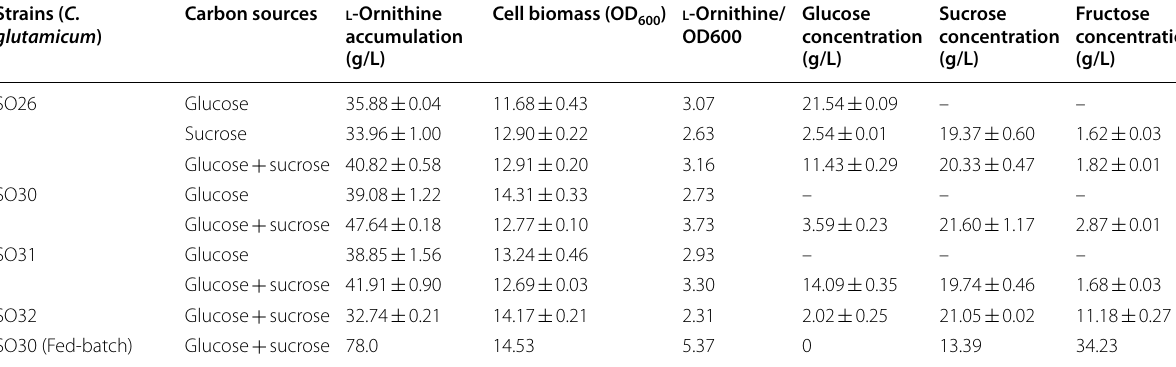
Fermentations were performed at 250 rpm for 72 h, and the initial sugar concentration was 100 g/L. Results except fed-batch cultivation are the means deviations in three individual experiments